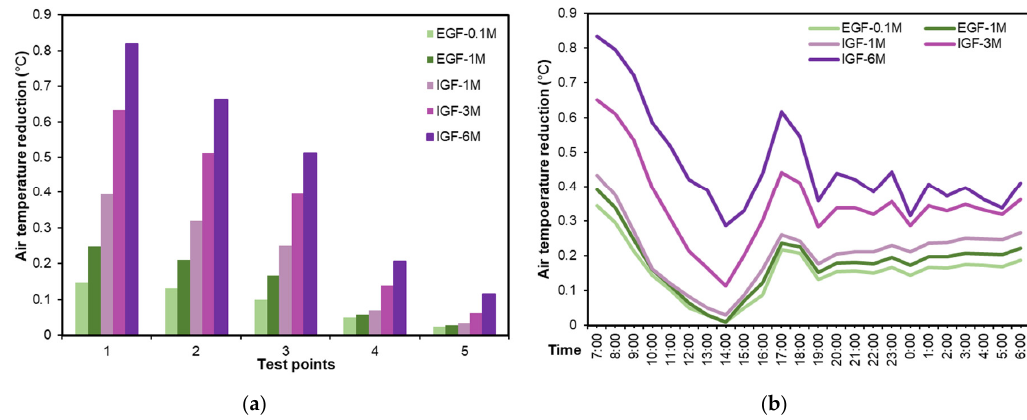
Figure 14. Average air temperature reduction in different vegetation height scenarios. ( a ) Daily average air temperatures at five test points, and ( b ) daily variations of average air temperature of five test points from 07:00 to 06:00 hof the next day.